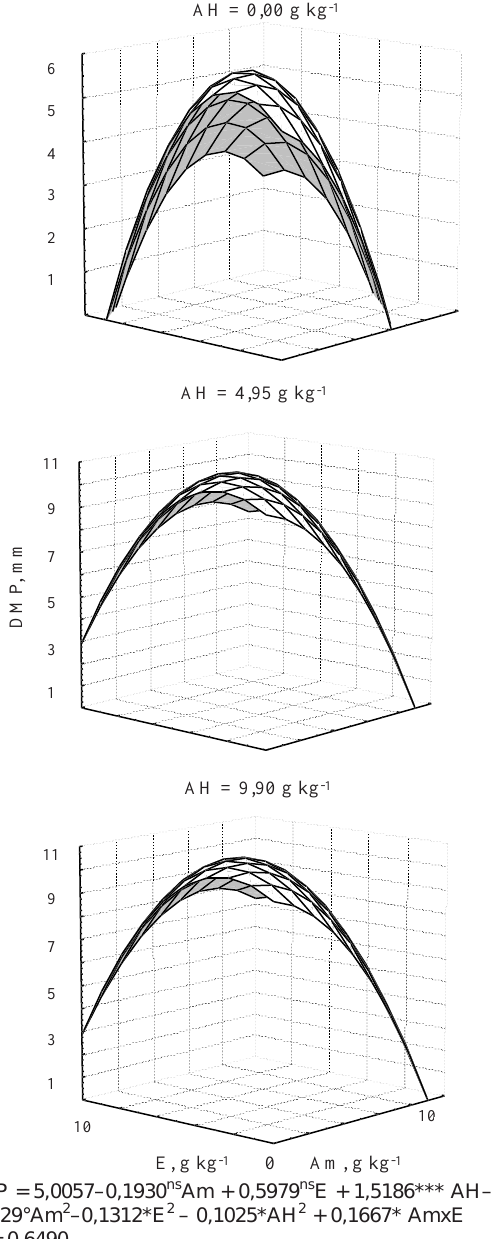
Figura 3. Diâmetro médio ponderado (DMP) dos agregados do horizonte B analisado por via seca, considerando a adição de amido (Am) e ácido esteárico (E), para diferentes doses de ácido húmico